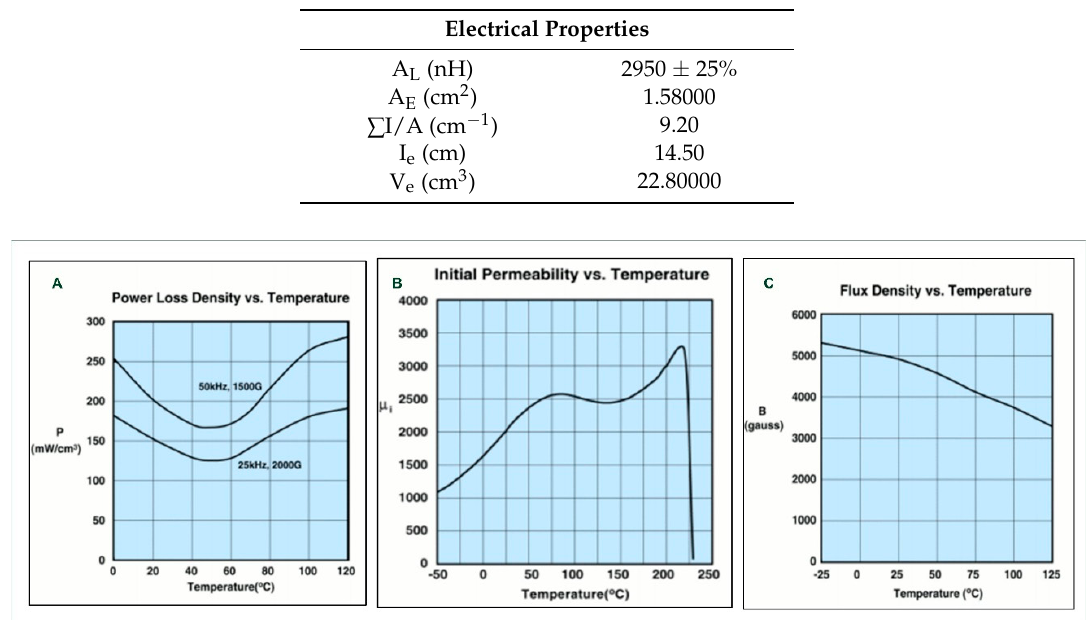
Figure 3. Temperature effects on Ferrite 77 material properties (courtesy: Fair-Rite products Corp).